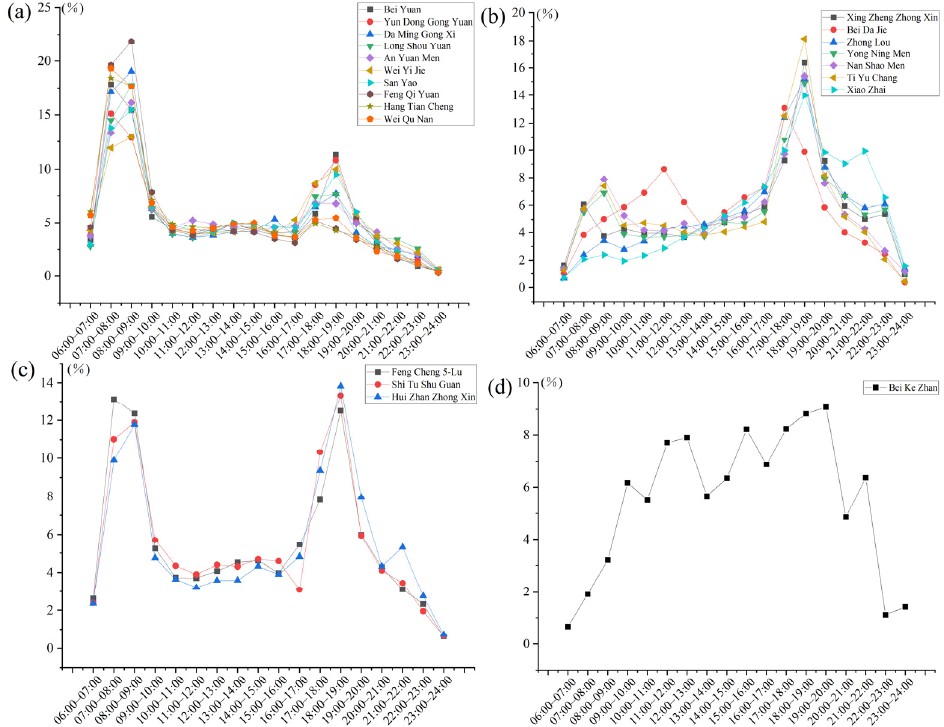
Figure 5. ( a ) Residential; ( b ) business; ( c ) mixed; and ( d ) traffic sites.